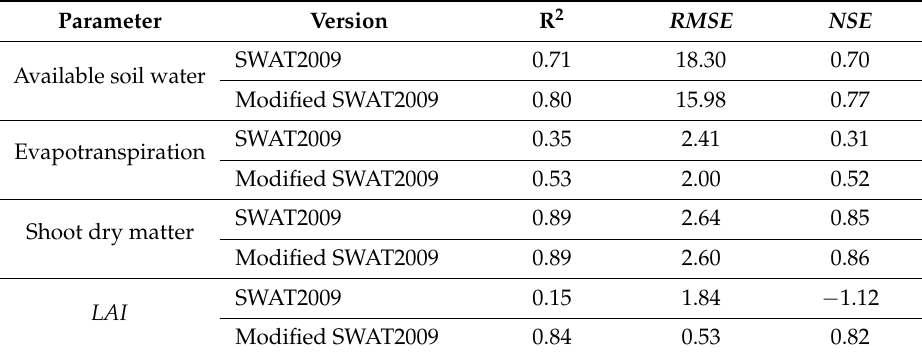
Table 4. Comparison between SWAT2009 and the modified SWAT2009 model.